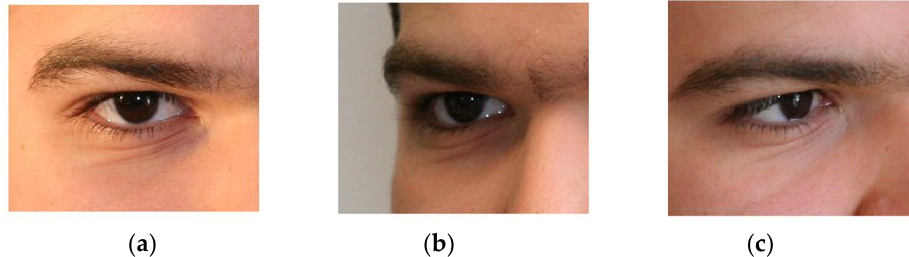
Figure 11. Example of a periocular image from UBIPr dataset with different pose variations: ( a ) 0-degree pose; ( b ) 30-degree pose ( c ) − 30-degree pose. Table 11. Division of the UBIPr dataset into training, validation, and testing sets for the different cases used in the cross-pose experiment.